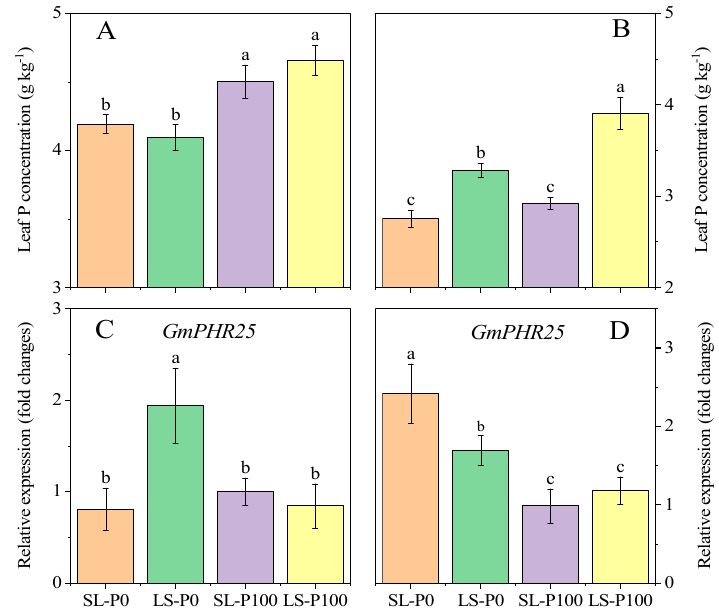
Figure 7. The e ff ect of P application and light condition on the leaf P concentration (( A ): V5 stage, ( B ): R3 stage), and the expression of gene GmPHR25 in leaf (( C ): V5 stage, ( D ): R3 stage) in the pot experiment. Plants were grown in two light conditions (SL: shade from sowing to the V5 stage and from V5 to R8 under natural light condition; LS: from sowing to the V5 stage under natural light condition and shade from V5 to R8) and two P application treatments (P0 = without P application; P100 = 100 mg P kg − 1 soil application). Values represent the mean of three replicates ± SE. Di ff erent letters on the columns are used to indicate means that di ff er significantly by LSD ( p ≤ 0.05). For GmPHR25 expression, data are expressed as relative values based on the expression of GmPHR25 in roots of soybean grown under the treatment of SL-P100 at the V5 stage, referenced as 1.0.